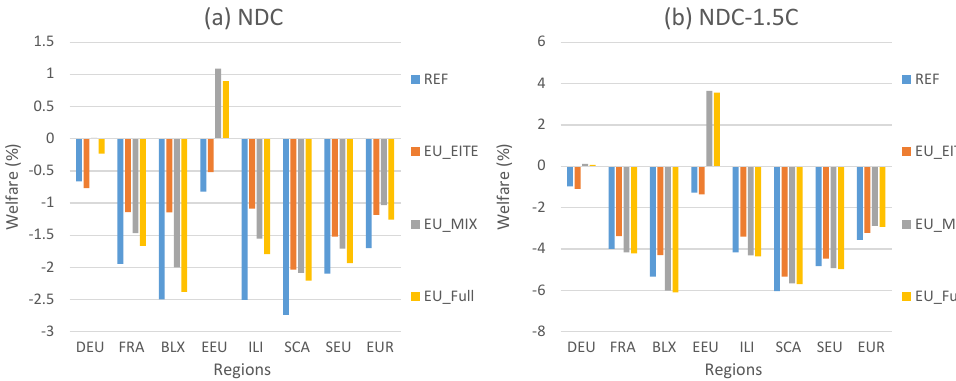
Figure 9. Percentage change in welfare for different policy scenarios and NDCs using the IEO baseline. Table 8. CO 2 price ($/tCO 2 ) in the EITE and NEIT for different policy scenarios and NDCs using the IEO